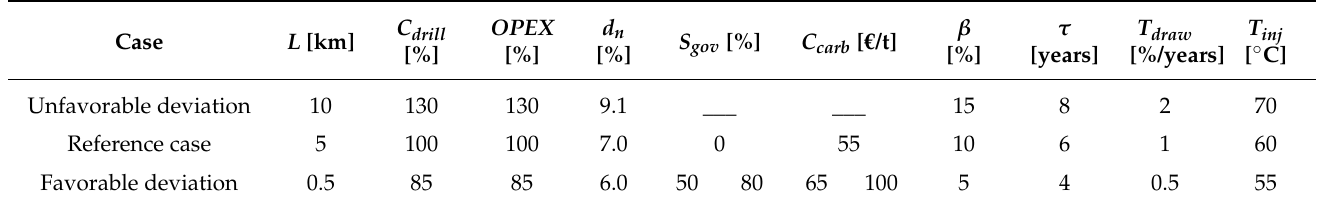
Table 1. Parameters for the reference case and two cases with parameters for sensitivity analysis.